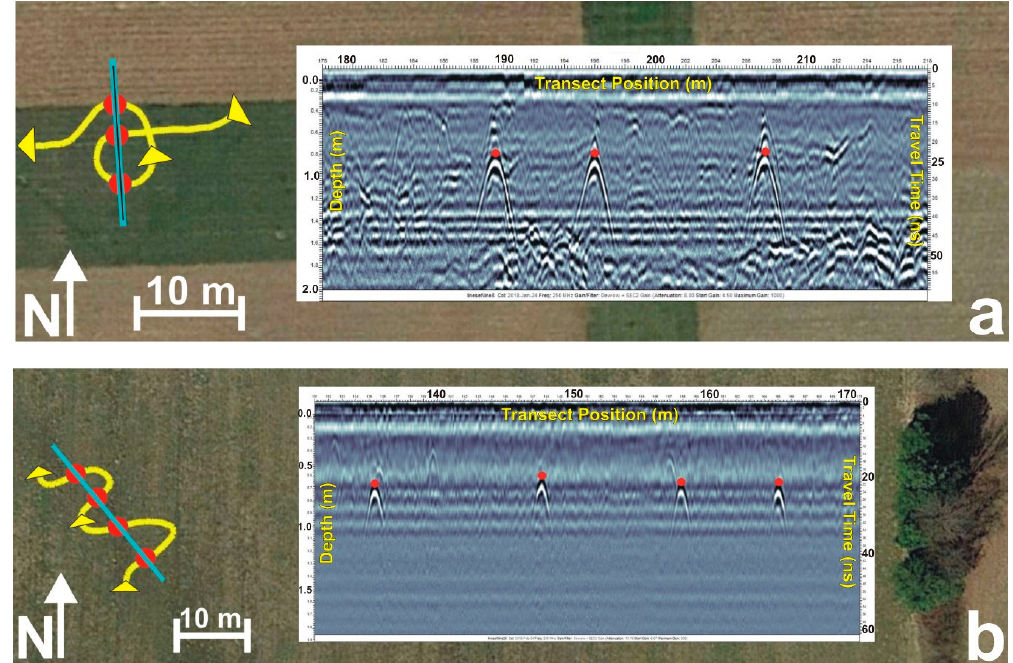
Figure 10. Spiral/serpentine segments of a GPR transect can be employed to determine drain line presence and direction: ( a ) spiral transect segment example from Site 2 (main collector pipe); ( b ) serpentine transect segment example from Site 3. Drainage pipe reflection hyperbolas interpreted with EKKO Project 5 (red dots on GPR profile insets) were mapped (red dots) along with transect segments paths (yellow lines with directional arrowheads). The mapped drainage pipe locations are in a line, thereby indicating the presence and direction of a buried agricultural drain line.